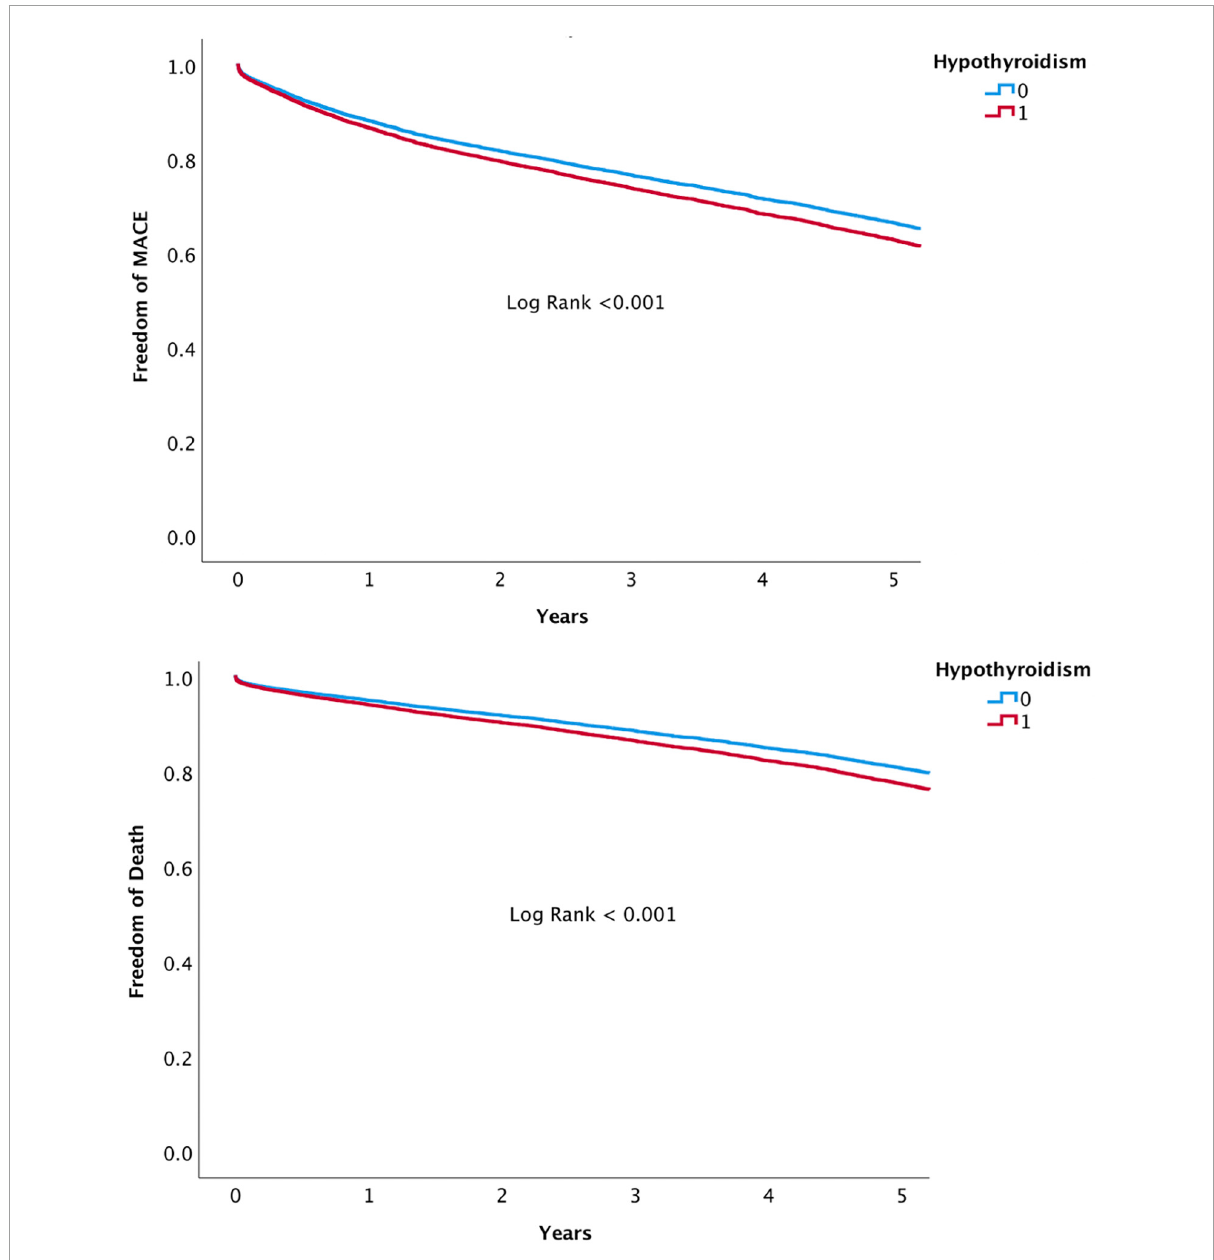
FIGURE5 Adjusted rates of all-cause mortality and MACE at 5